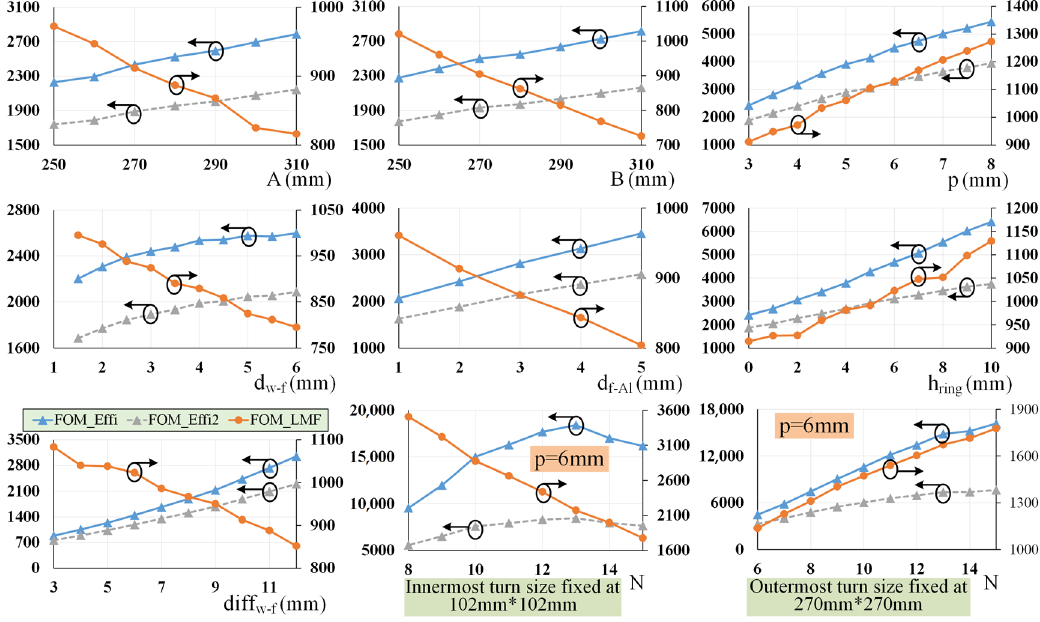
Figure 5. Simulated FOMs. The solid line with triangular dots, dashed line with triangular dots and solid line with circular dots denote FOM ef fi , FOM ef fi 2 and FOM LMF , respectively. For the sake of clarity, the units of the vertical-axis quantities are omitted.